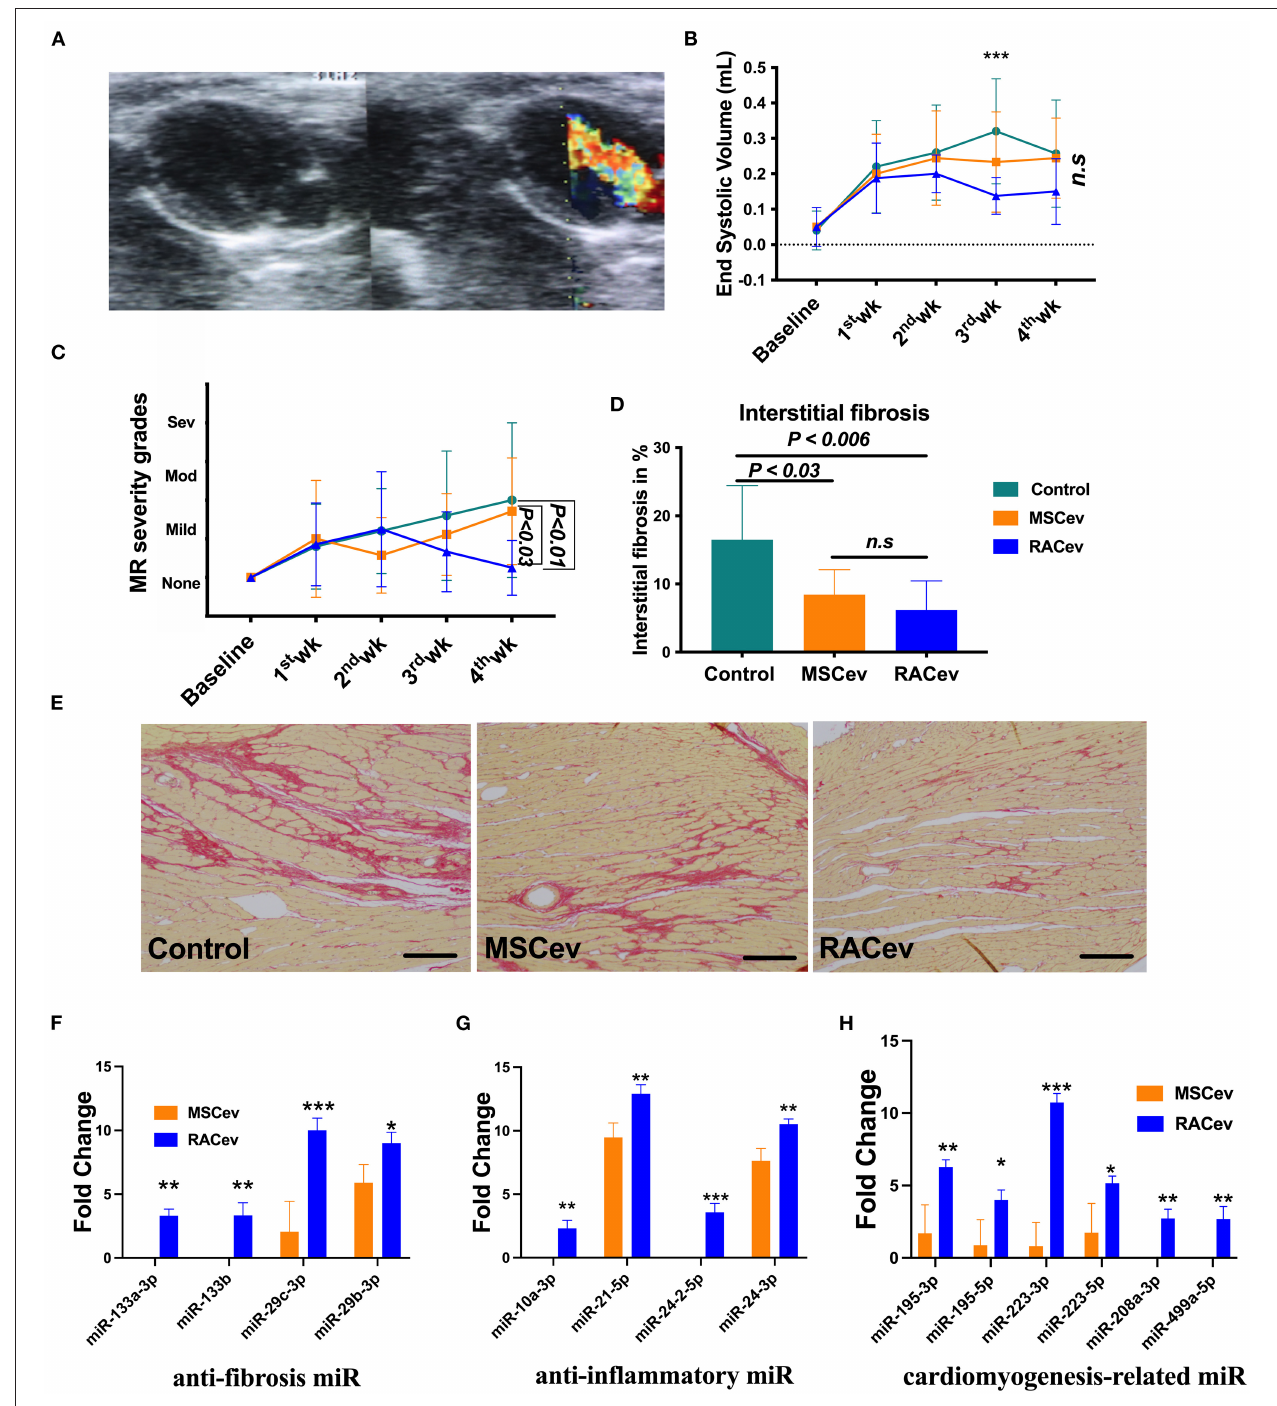
FIGURE 4 | RACev transplantation preserved mitral regurgitation (MR) and interstitial fibrosis. (A) Representative mitral regurgitation echocardiographic 2D image. (B) At 4 weeks, mitral regurgitation incidences were higher in the Control and MSCev-treated groups than the RACev group. (C) Mitral regurgitation caused end-systolic volume increase in the control and MSCev-treated groups but not in the RACev group. (D, E) Interstitial fibrosis accumulation was greater in the control group than in the MSCev and RACev groups. (F) Anti-fibrosis miRs were significantly upregulated in RACev vs. MSCev. Furthermore, miR-133a-3p and miR-133b are expressed in RACev but not MSCev (G) Previously defined anti-inflammation related miRs such as miR10a-3p and miR-24-2-5p were expressed only in RACev group (RACev vs. MSCev). (H) Cardiomyogenesis-related miR significantly upregulated in RACev vs. MSCev, and miR-208a-3p and miR499a-5p detected in RACev group but not in MSCev. Scale bar = 100 µ m * P < 0.05; ** P < 0.01; *** P < 0.001 vs. the MSCev group. Statistical significance was determined using 2-way ANOVA (for MR and ESV) or one-way ANNOVA (for interstitial fibrosis) followed by Dunn’s or Tukey‘s multiple comparison post- hoc tests. The results are presented as mean ± SEM ( n = 8–10 per